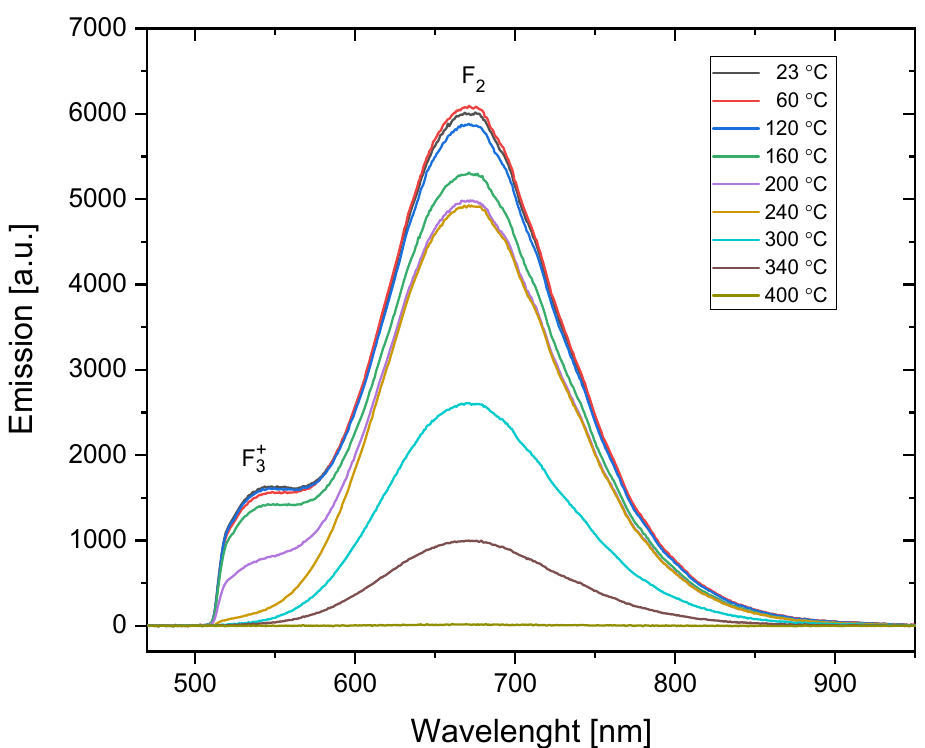
Figure 6. PL emission spectra for the sample irradiated with alpha particles from Am-241 source (fluence 3.4 × 10 12 cm − 2 ) and submitted to a series of subsequent heat treatments at increasing temperatures (Method 1). Excitation was applied at 440 nm. The bands related to F 2 and F 3+ color centers are marked. Measurements were obtained at room temperature. The spectrum is clipped from the low-wavelength side by the applied